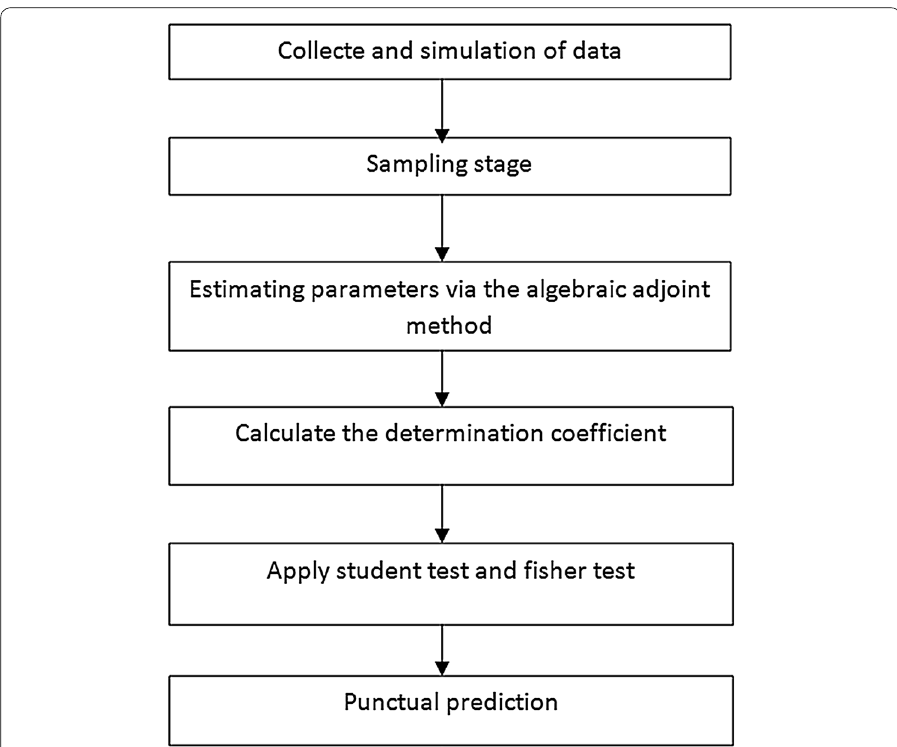
Fig. 1 Chart flow of the proposed software